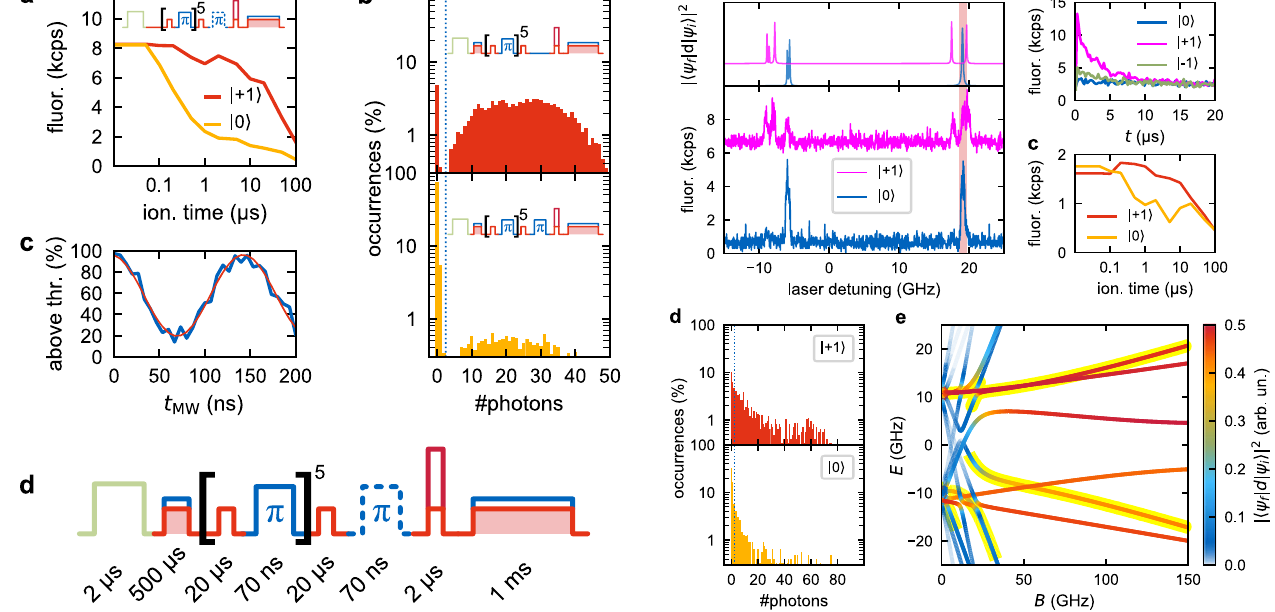
Fig. 4 Data for a representative shallow implanted NV center (110 keV CN − ). a PLE spectra as measured (lower panel) and simulated (upper panel) similarly to Fig. 1d. Off-axial strain is estimated to be 12.6 GHz. The detuning is denoted from 637.20 nm. The 637 nm laser was tuned in resonance with the higher-energy transition at 19 GHz for all following measurements (red background). b Average fl uorescence under optical pumping on the selected transition after explicit spin initialization according to Fig. 1c, as presented in Fig. 2a in the lower panel for the deep NV center. The NV − center was initialized to | + 1 〉 with (70 ± 1)% probability. The background after 20 μ s stems from fi nite excitation of the close-by |±1 〉 transition. c Similar to Fig. 3a. Average fl uorescence of the charge-state readout after charge initialization (without postselection), spin initialization in | + 1 〉 or |0 〉 according to Fig. 1c, and spin-dependent ionization with varying ionization time. For d , an ionization time of 5 μ s was used. d Similar to Fig. 3b. Distribution of the number of fl uorescence photons for 5 ms of readout. The as-measured fi delity is (67.1 ± 0.9)%. e Simulation of the dipole transitions between optical ground and excited state for all three spin projection numbers for fi xed strain-splitting of 20 GHz and varying magnetic fi eld 20° off-axis. The transitions highlighted in yellow are the most pronounced spin |0 〉 transitions. The coloring is a measure for the transition strength. There are several parameter ranges with spectrally well-isolated